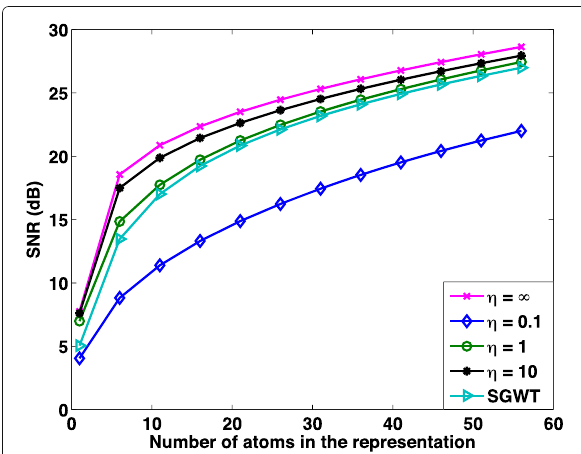
Fig. 4 Approximation performance (SNR) versus sparsity level, achieved with the polynomial graph dictionary for different values of η in centralized settings